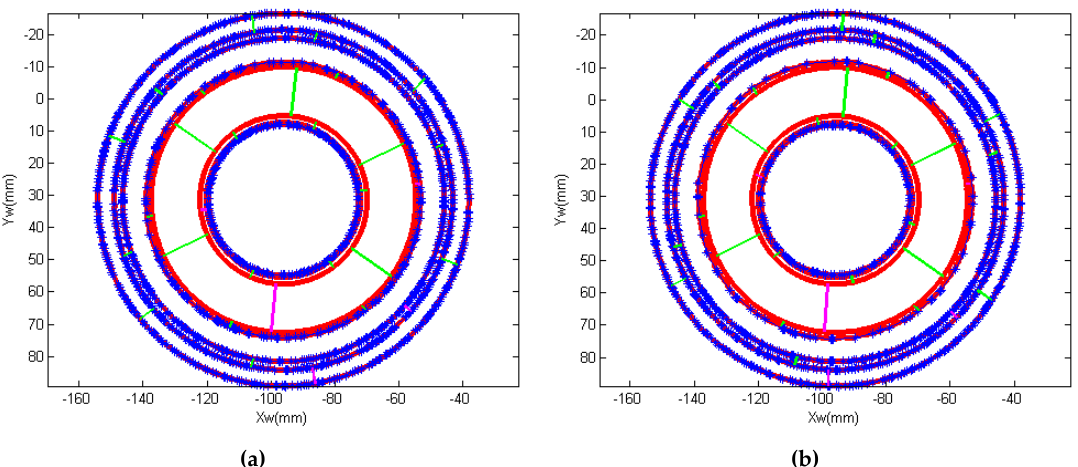
Figure 15. General view of cross-section measurement. ( a ) Perimeter and thickness for I 1 , in which red dots are extracted contour points, blue asterisks are vertexes of contour convex hull, magenta lines denote minimum thickness ( t i ) min , and green lines are the other five thickness measurements clockwise; ( b ) Perimeter and thickness for I 2 .